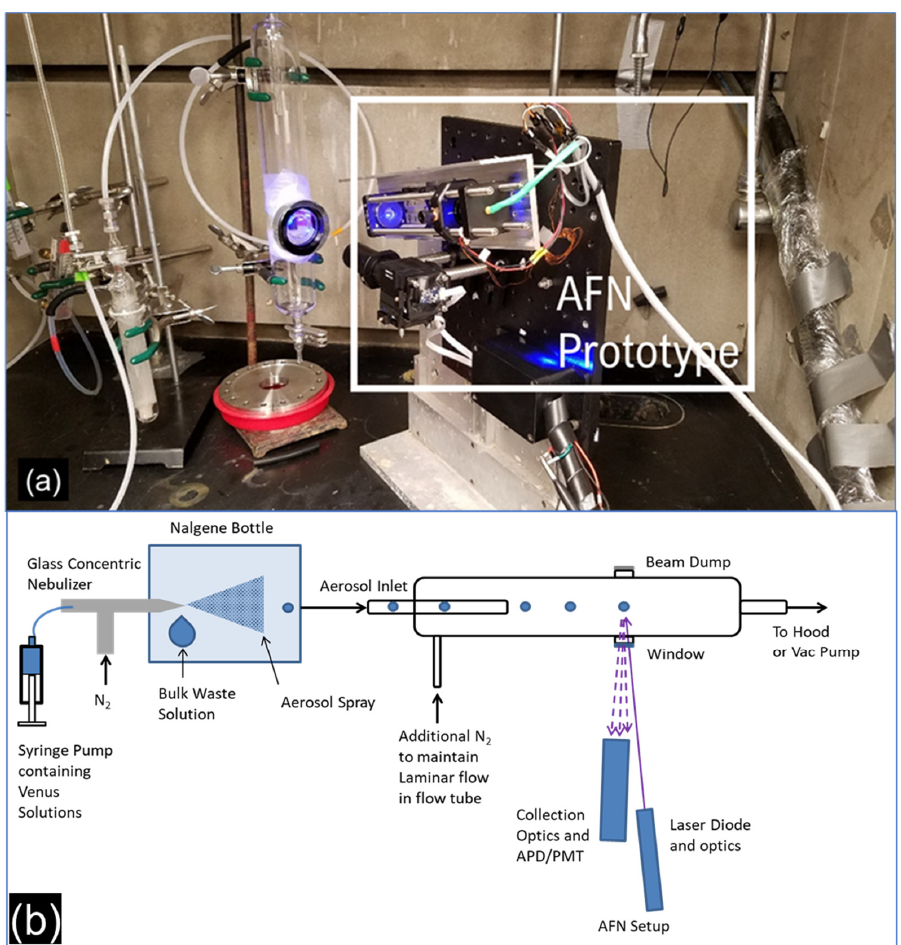
Figure 6. ( a ) The laboratory prototype of the AFN (LAFN) was evaluated in the laboratory where it was tested ( b ) with a polydispersed spray of droplets composed of mixtures containing H 2 SO 4 and CH 2 O. The collection optics direct the light to two avalanche photo detectors (APD) for the scattered, polarized light and to a photomultiplier tube (PMT) for fluorescence emissions.